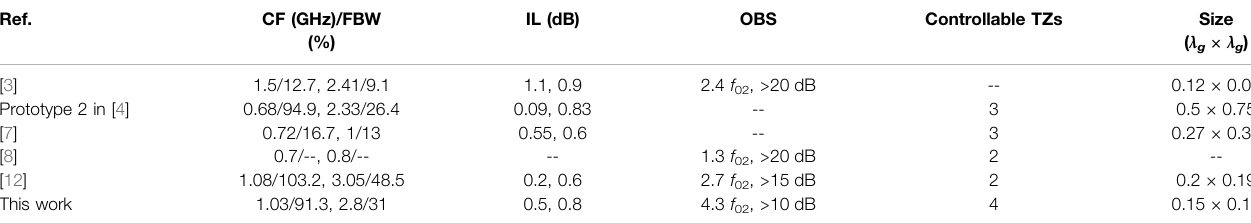
TABLE 2 | Comparison of the proposed fi lter with previous designs.